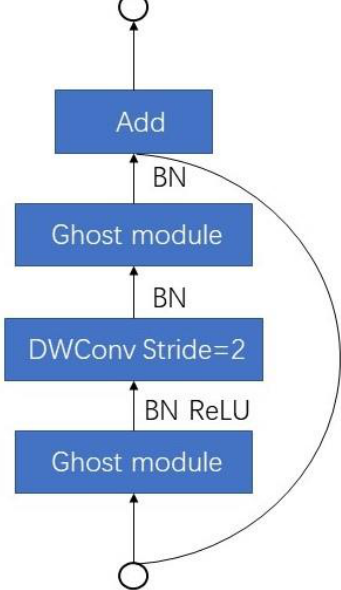
Figure 5. Ghost Bottlenecks.